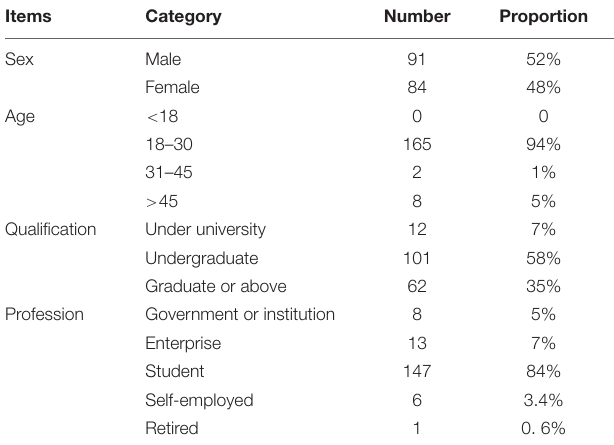
TABLE 1 | Composition of valid